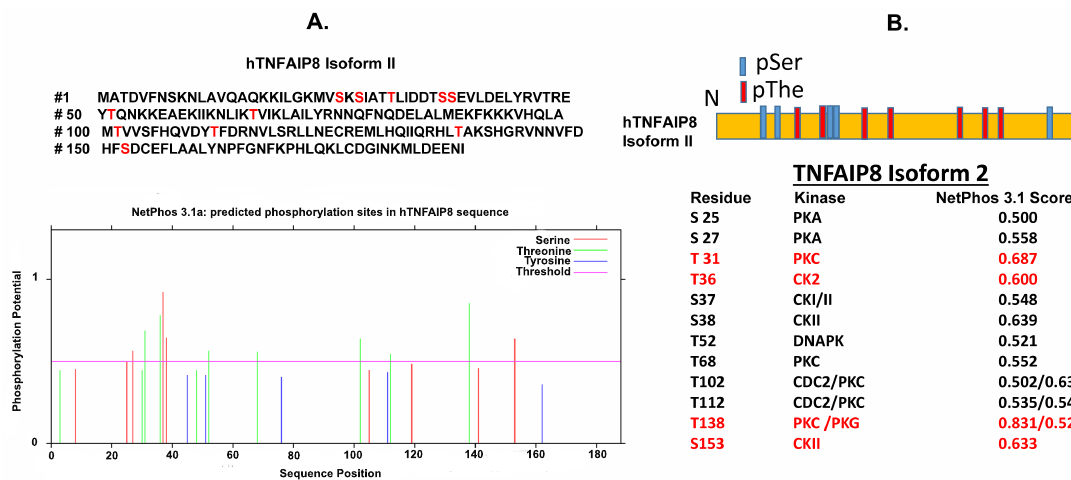
Figure 4. ( A , B ) Prediction of phosphorylation sites of TNFAIP8 were performed by using NetPhos server 3.1 (http://www.cbs.dtu.dk/services/NetPhos/, accessed on: 15 July 2018) and Prosite search (https://prosite.expasy.org/, accessed on: 10 July 2018) ( B ) Locations of predicted pSer and pThe phosphorylation sites of TNFAIP8 isoform 2 are presented (upper schematic). Phosphorylation sites, associated kinases, and NetPhos scores are presented (lower table). Both NetPhos and Pro-site server-predicted phosphorylation sites and kinases are shown in red color (lower